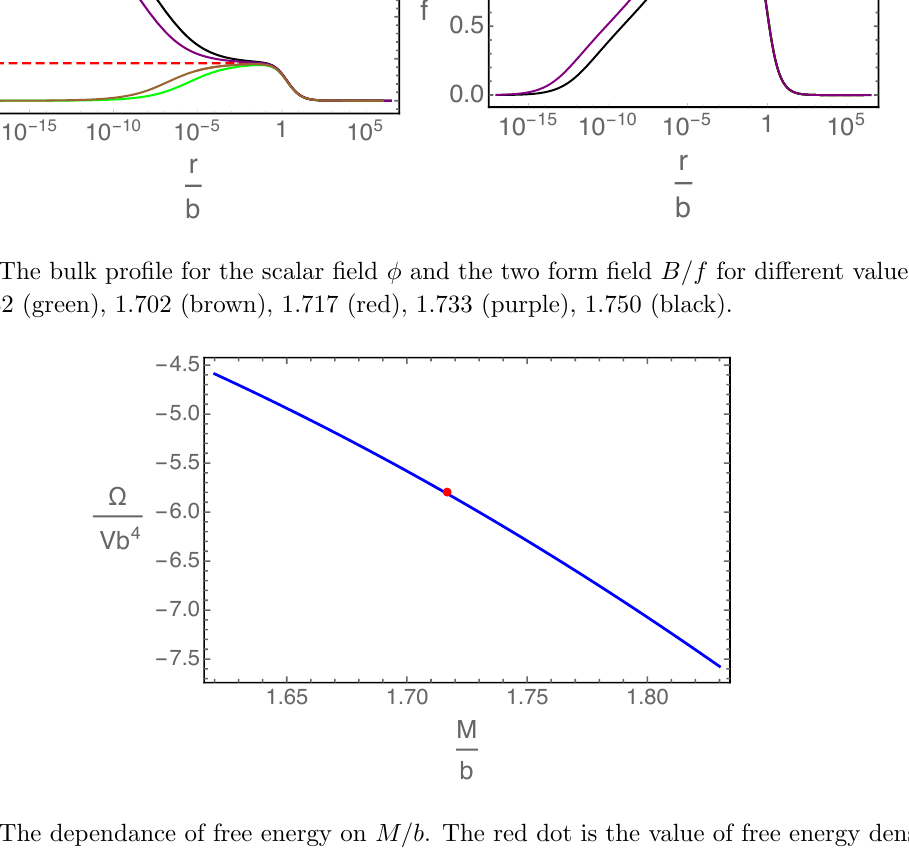
Figure 3 . The dependance of free energy on M=b . The red dot is the value of free energy density at the critical point. Approaching the transition point from both the topological phase and the trivial phase, the system is continuous and